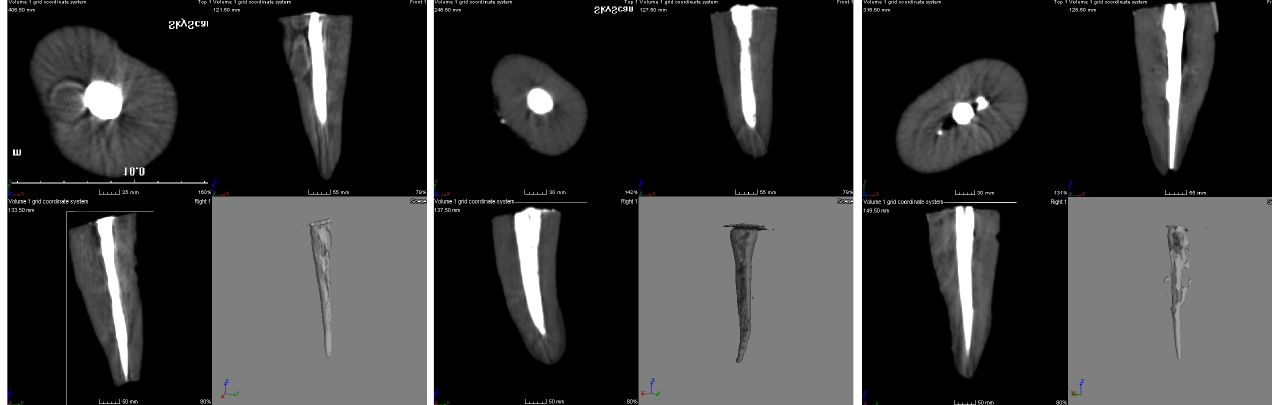
Fig. 3. Micro-computed tomography reconstructions of root canal geometry of samples filled with Resilon-Epiphany system using cold lateral condensation technique (A), System B (B) and Down-Pak technique (C).